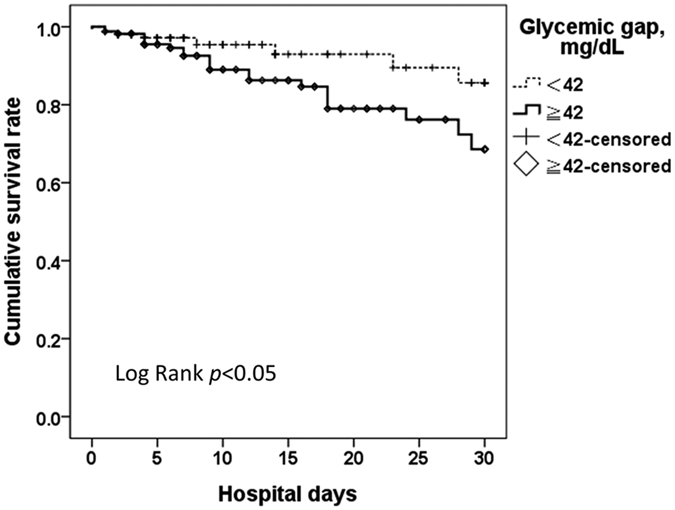
Kaplan–Meier survival curves of glycemic gaps in diabetic patients presenting to the emergency department with acute myocardial infarction.